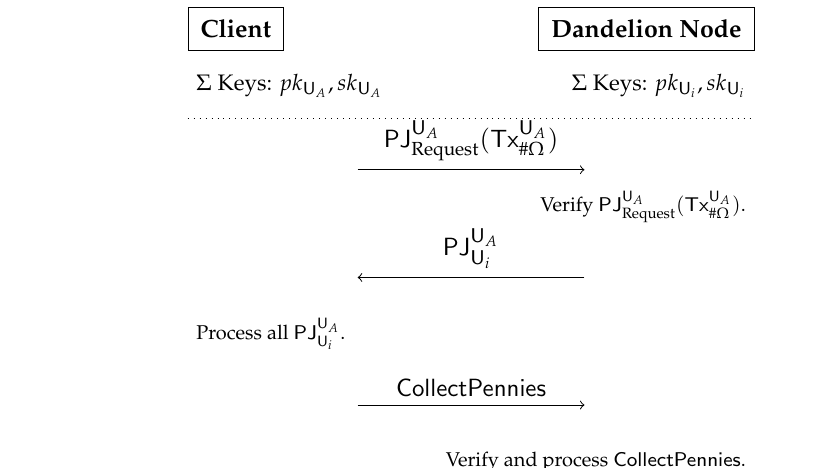
Figure 8. The Dandelion collect pennies protocol.